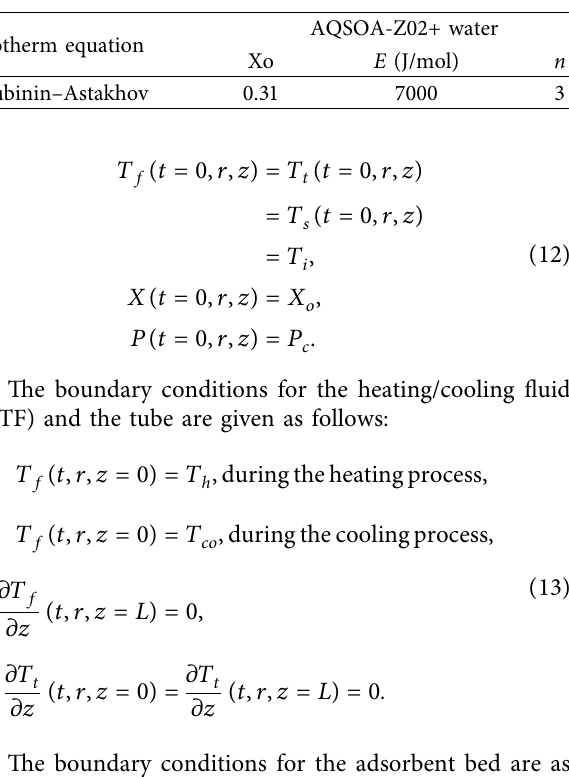
Table 1: Parameter of Dubinin–Astakhov adsorption isotherm equation for AQSOA-Z02+ water